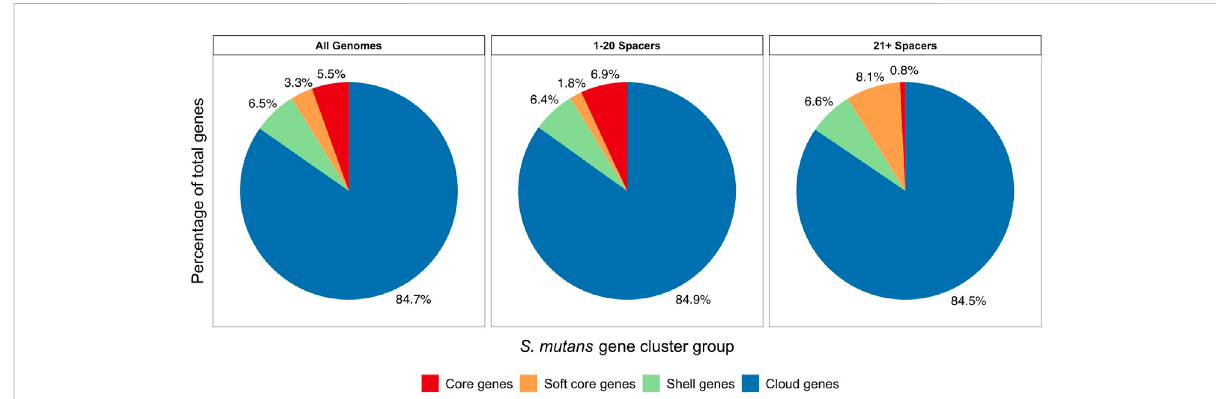
FIGURE 8 Pangenome analysis comparing low and high CRISPR spacer load S. mutans strains. Pangenome analysis was conducted on three groups. 1) all S. mutans genomes, 2) a group with low CRISPR spacer load (1 – 20 spacers, average 9.36; 163 genomes) and 3) a group with a high CRISPR spacer load (21 – 129 spacers, average 37.93;169 genomes). Forthethree groups piecharts weregenerated whichshow thepercentageofgenes located in the different gene clusters (core, red; soft core, orange; shell, green; cloud, blue). Cloud genes (blue) are most likely acquired via